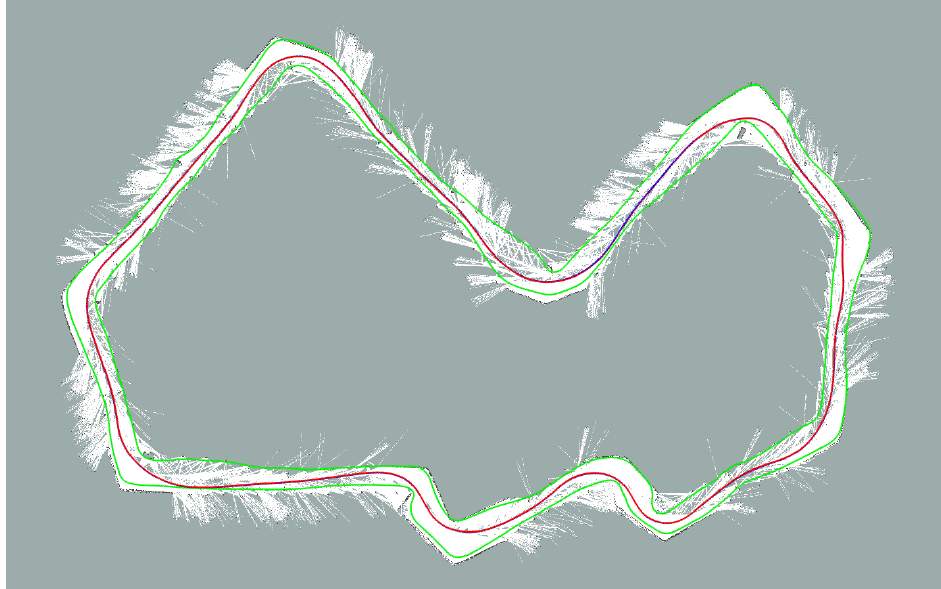
Figure 4. The map built for the race. The circuit track borders are represented by the two green lines, white areas are the obstacle free spaces, while the red line represents the racing line, to be followed during the